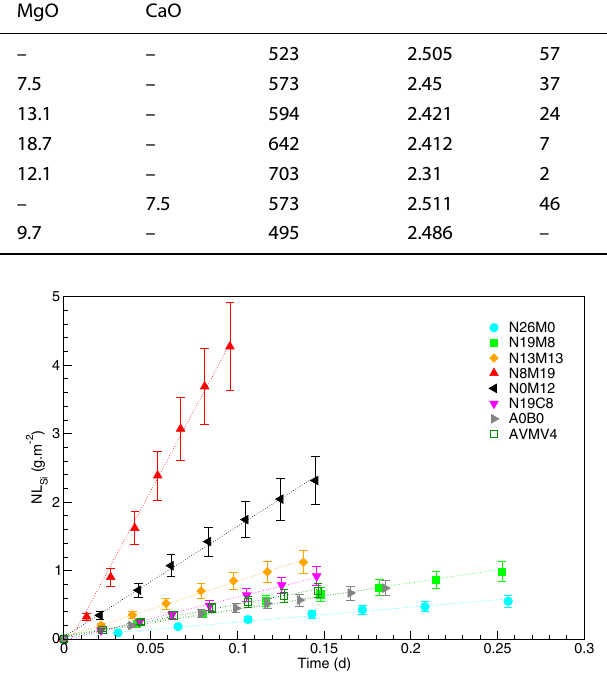
Table 1. Nominal composition of the studied glasses, expressed in molar percent of oxide, alongside associated measured glass transition temperature ( T g ), density ( ρ ) and NMR-extracted fourfold coordinated boron percentage. Glass ID